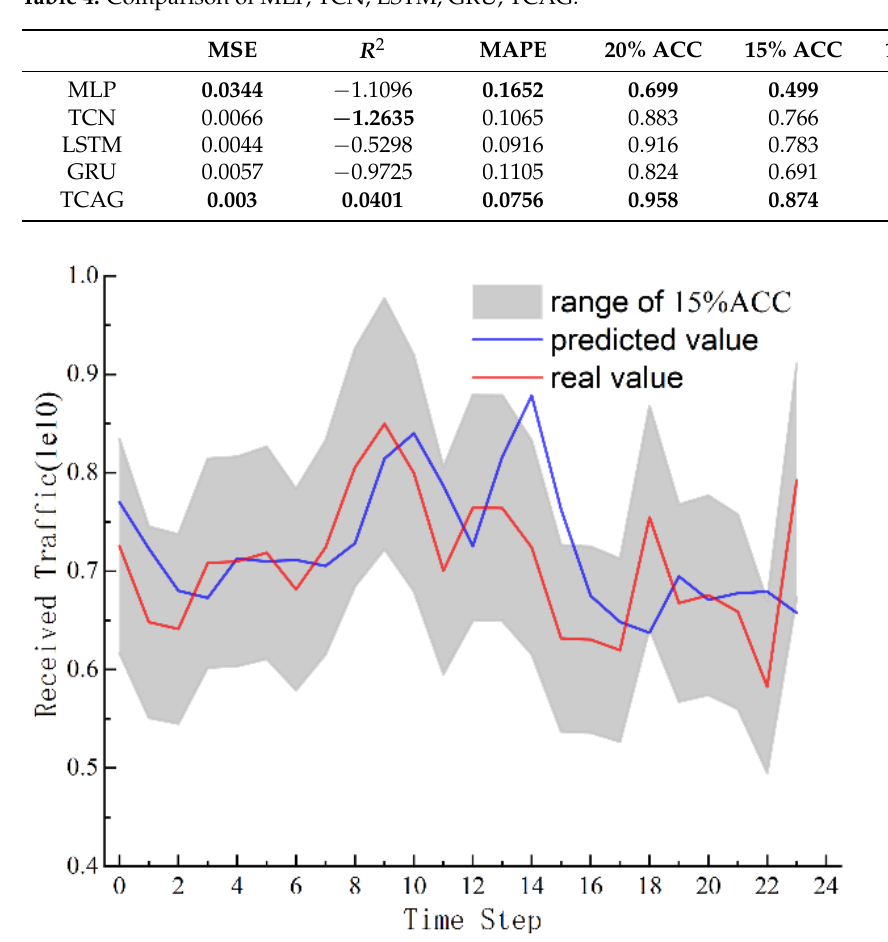
Figure 8. TCAG model prediction results.